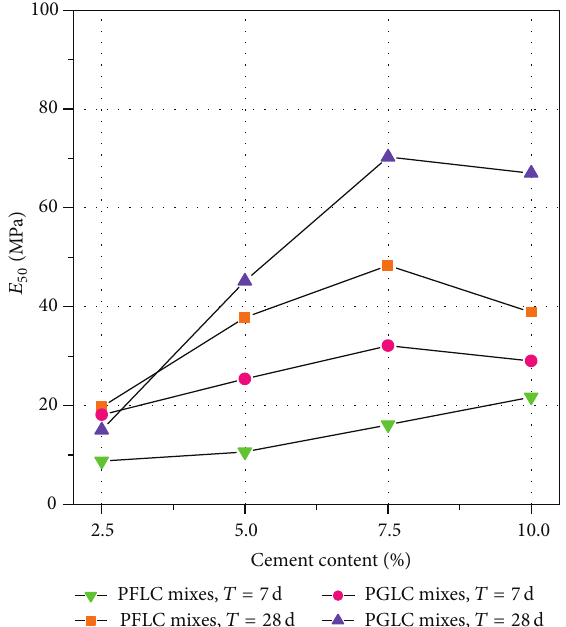
Figure3:Relationshipbetween E 50 (MPa)andcementcontents(%).